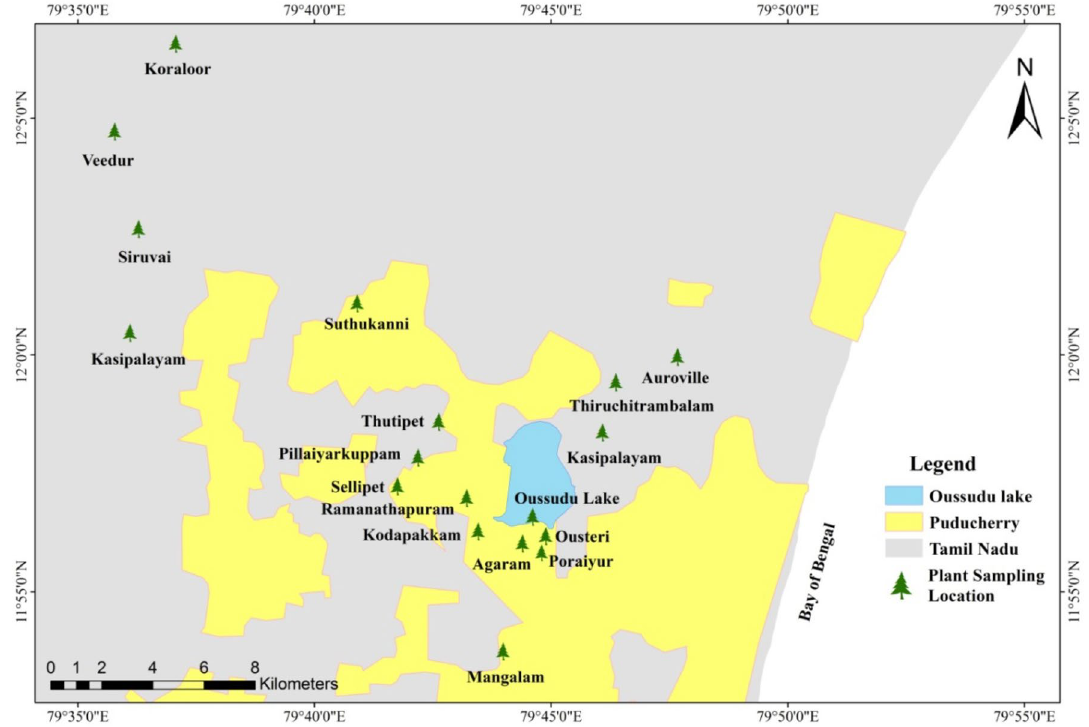
Figure 1. Geographical location map and plant sampling stations in and around Oussudu Lake, Puducherry region (prepared using QGIS version